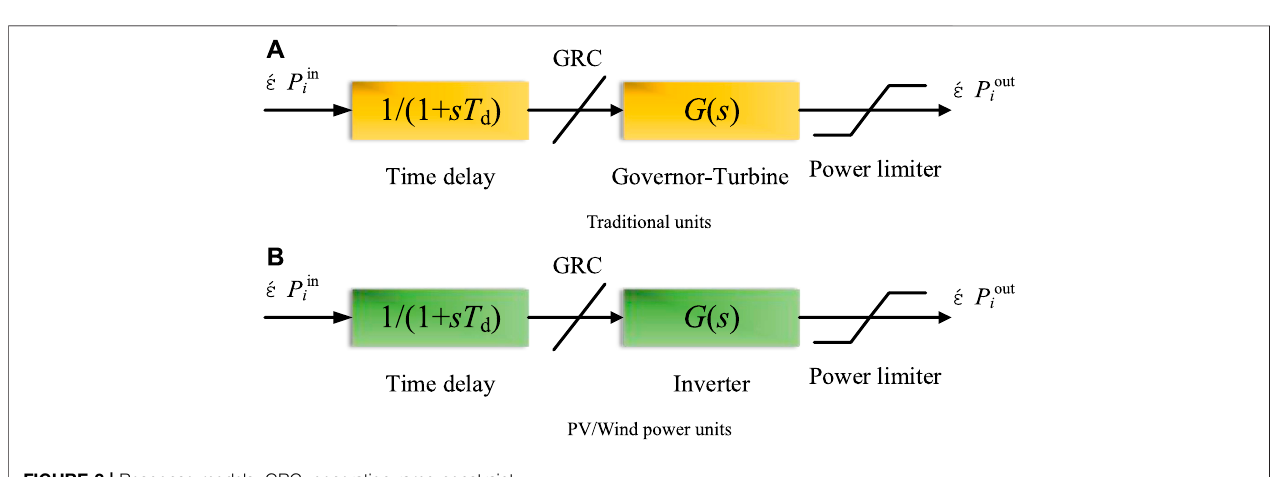
FIGURE 2 | Response models. GRC: generation ramp